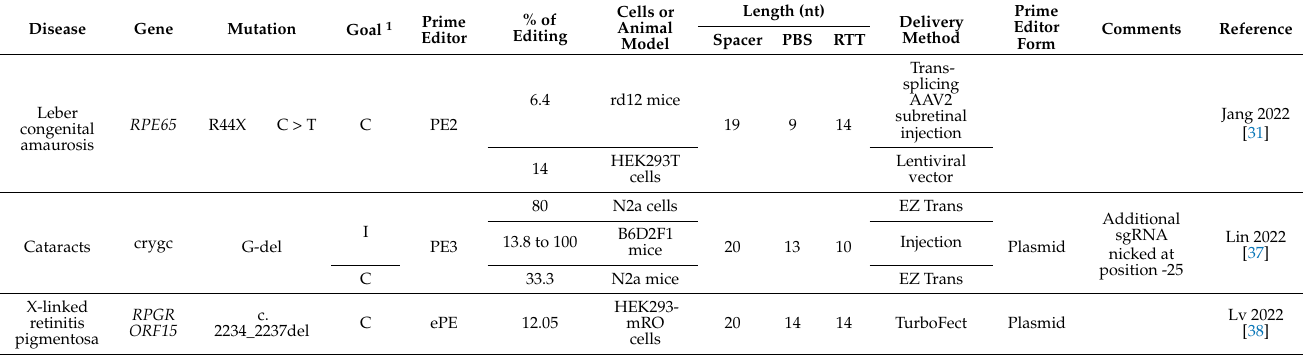
Table 3. Prime editing studies on correcting or introducing genetic mutations causing eye